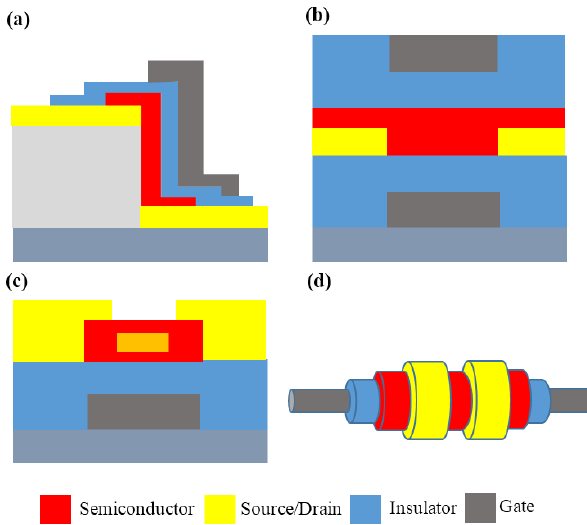
Figure 2: Schematics of improved TFT structures: (a) V-TFT, (b) DG- TFT, (c) BL-TFT, (d)